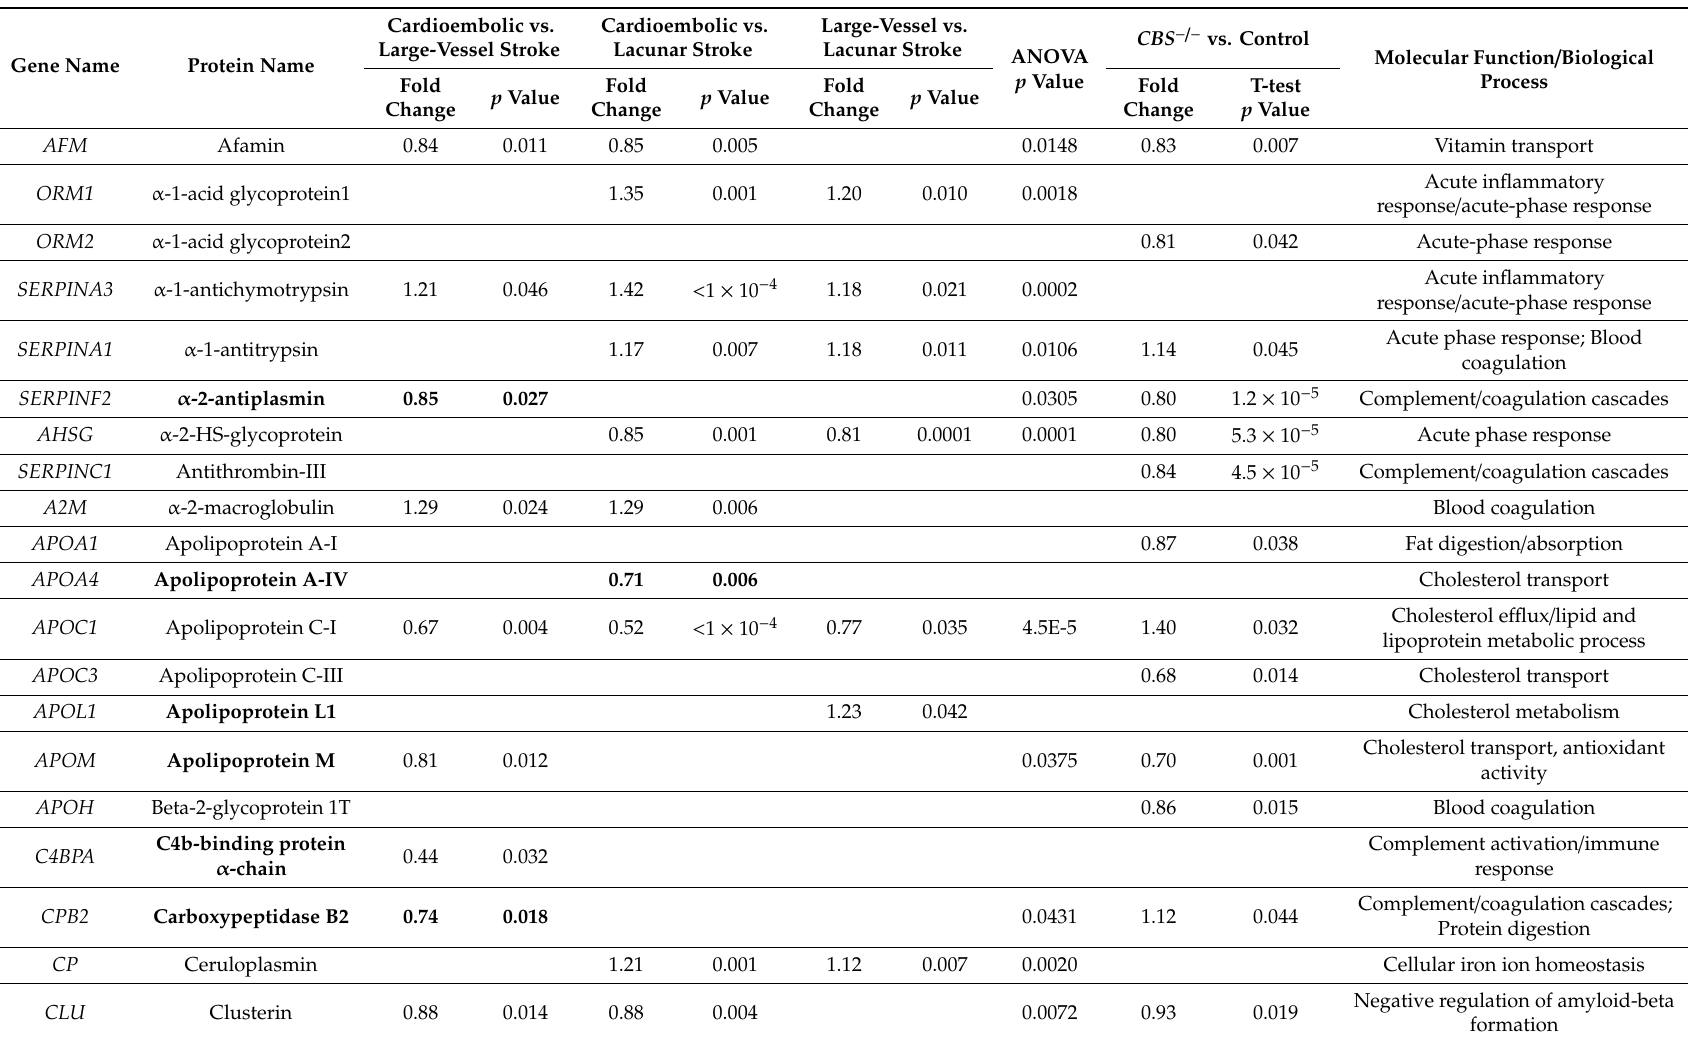
Table 3. Stroke subtype- and CBS deficiency-responsive proteins in human serum. Proteins unique for stroke subtype are highlighetd in